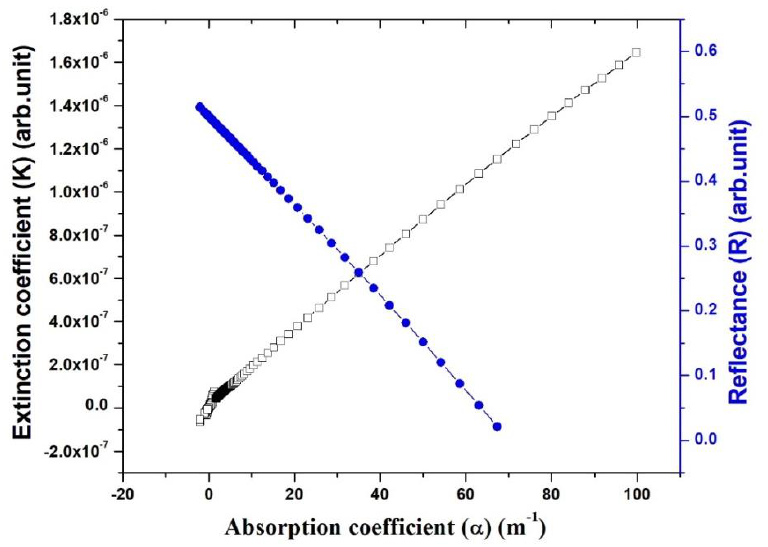
Figure 6. Photonic response of ( a ) reflectance and ( b ) extinction coefficient.